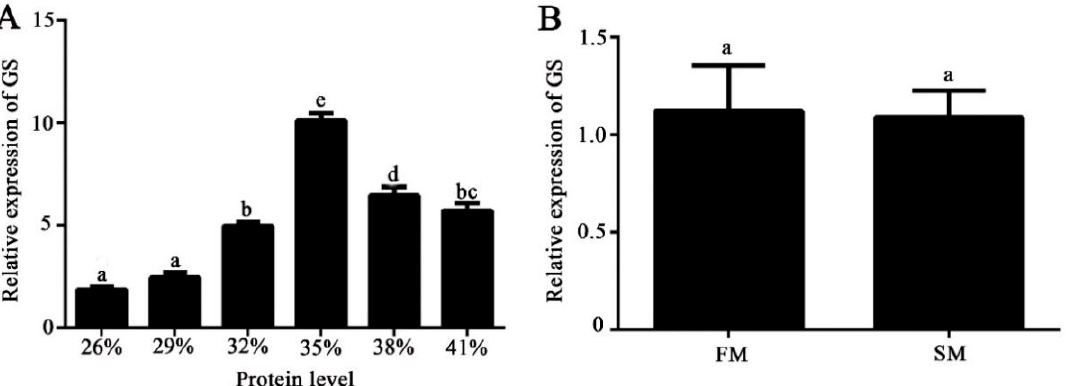
Figure 4. Dietary protein levels ( A ) and dietary protein sources ( B ) on GS mRNA abundance in the grass carp intestine. Error bars indicate the mean ± SD. Tukey’s multiple range test ( A ) and t -test ( B ) were performed, respectively. Different letters represent significant differences ( p < 0.05, n = 3 for each group) .